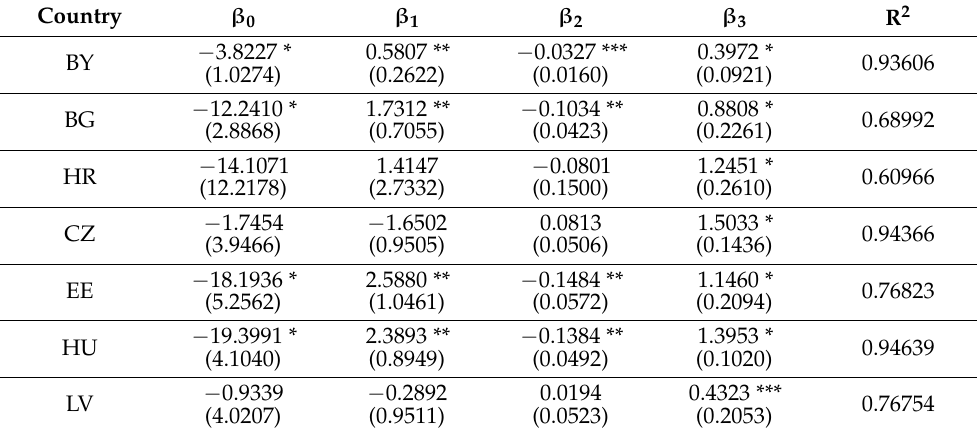
Table 4. Estimation of model parameters for independent variables GPD and